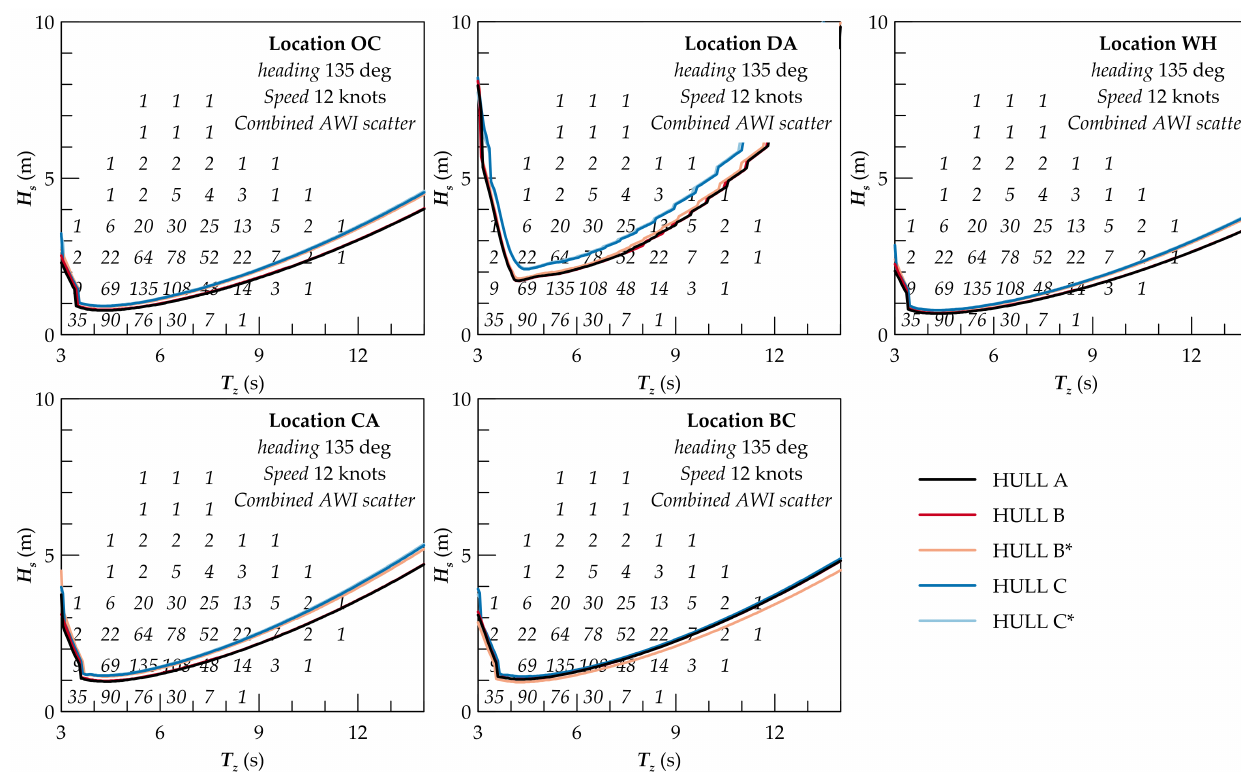
Figure 22. Limiting comfort criteria curves on the combined Area 27 and 47 scatter diagram for the AWI 22834 locations at 0 knots.